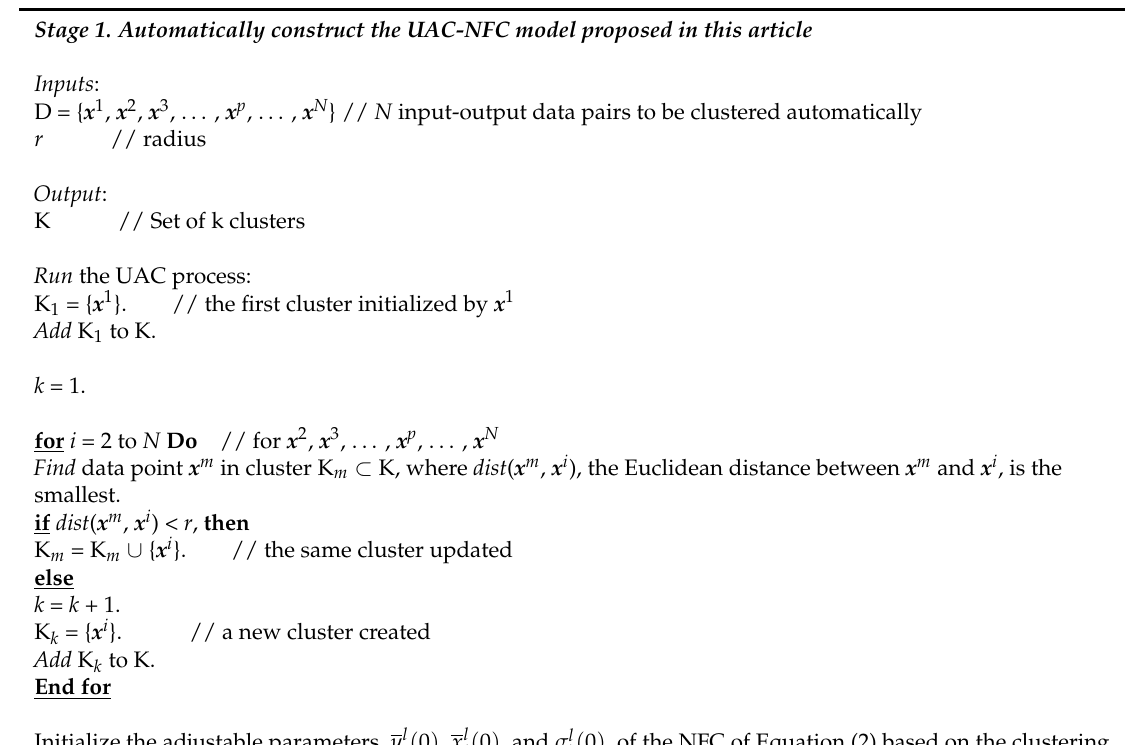
Table 1. The hybrid Unsupervised Automatic Clustering-integrated Neuro-Fuzzy Classification (UAC-NFC) model proposed in this